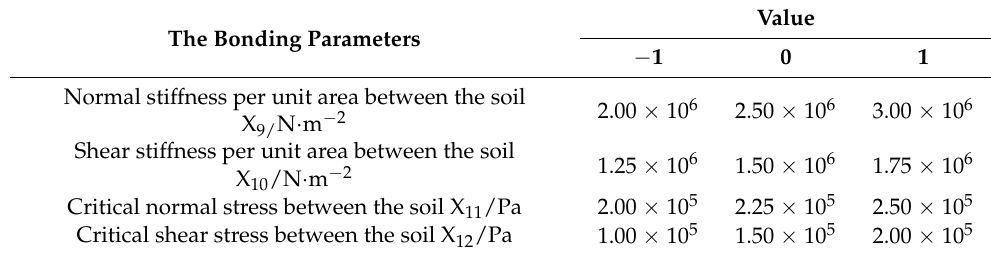
Table 3. The Code table of soil block shear crushing response surface test. The Bonding Parameters